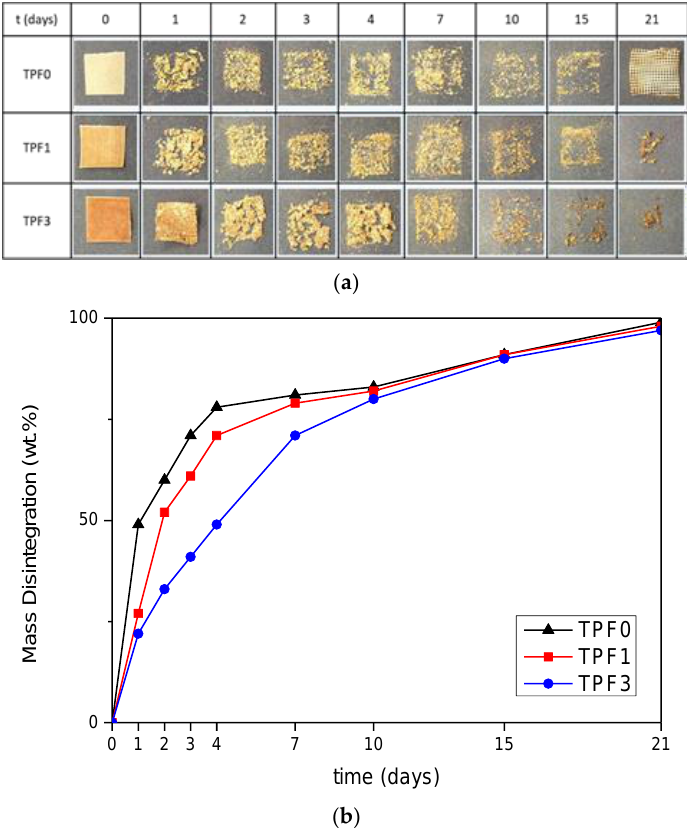
Figure 8. Visual images of the TPWF samples based on F0, F1 and F3 flours ( a ) and evolution of disintegration degree ( b ) at different compositing times.